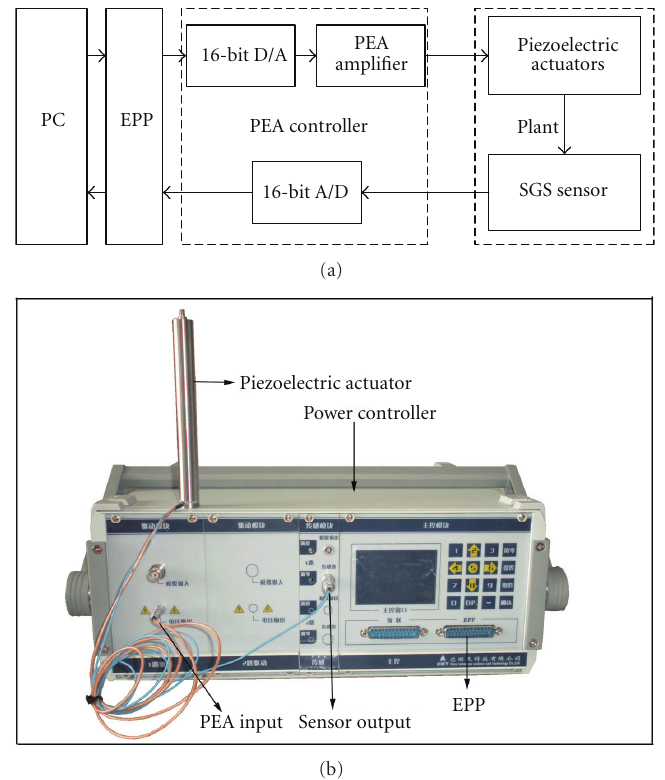
Figure 2: (a) The experimental block diagram. (b) the experimental setup.